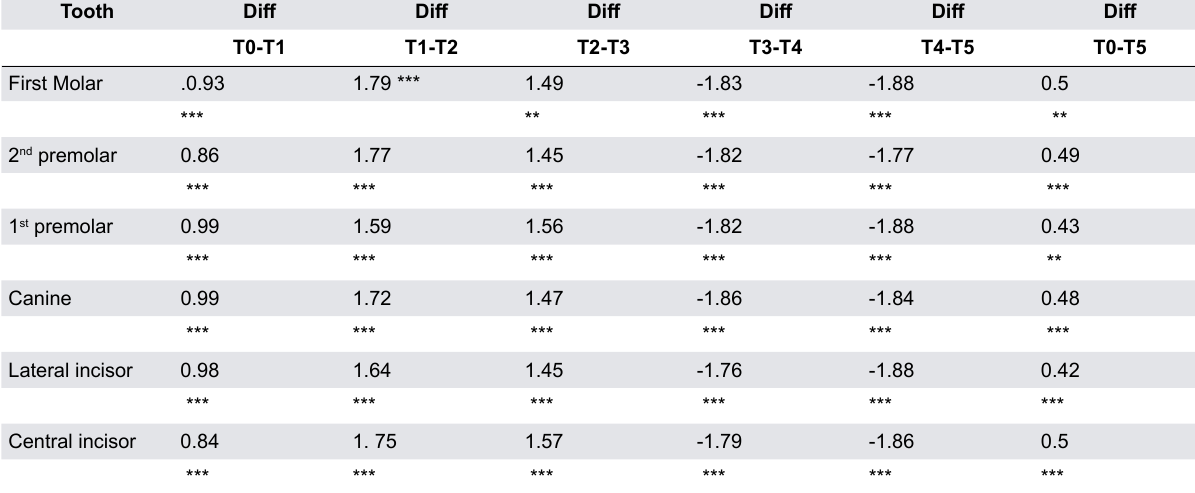
Table 4- Diff. between means and p-values for the PBF from baseline (T0) to (T5) for each measured tooth in 0.018-inch NiTi Tooth